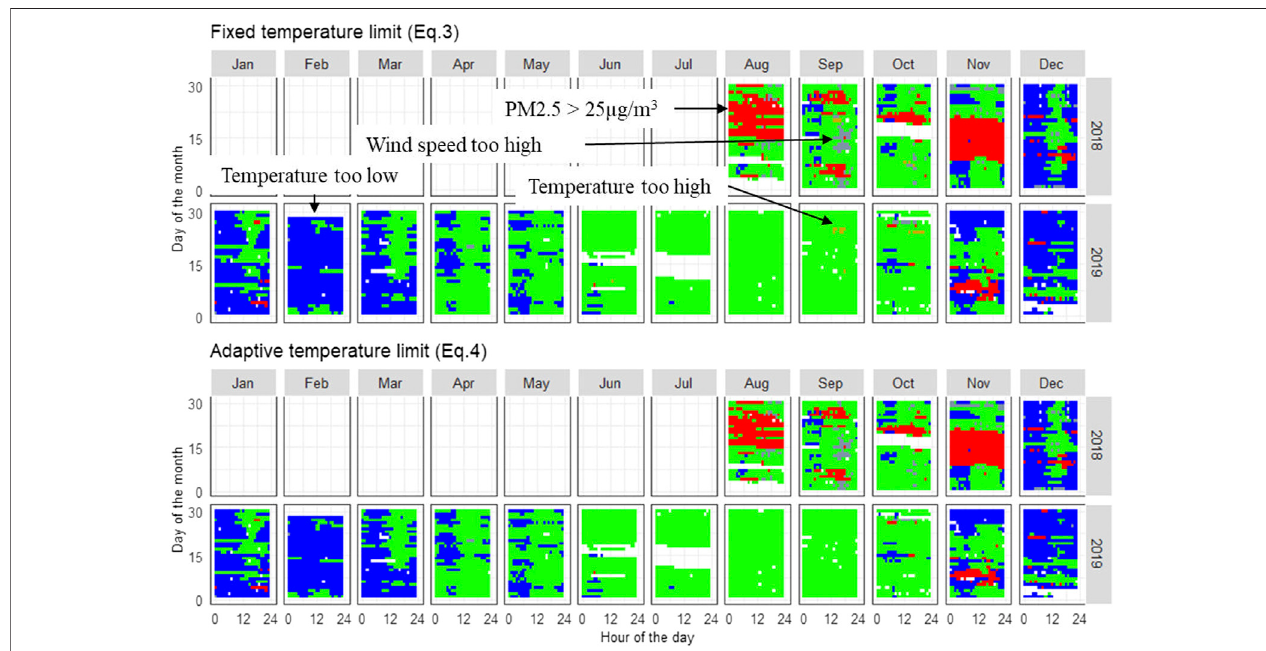
FIGURE 11 | NV availability according to Eq. 3 (upper row) and Eq. 4 (bottom row) . Red color represents that PM 2.5 concentration is higher than 25 μ g/m 3 . Brown color represents that outdoor temperature is higher than the upper limit. Blue color represents that outdoor temperature is lower than the lower limit. Gray color represents that outdoor wind speed is too strong for NV. Green color represents that the outdoor climate condition and pollution level are favorable for the use on NV.